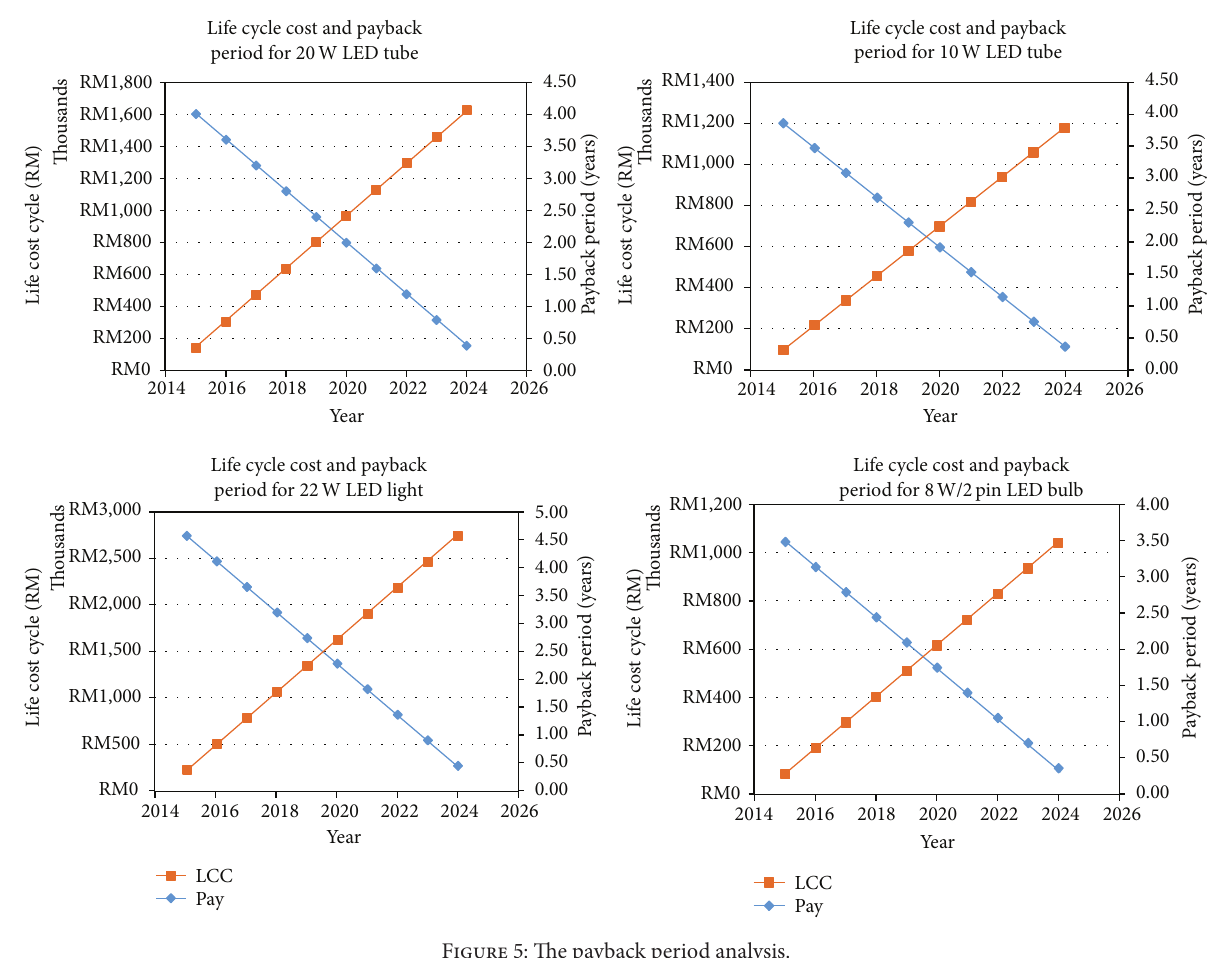
Figure 5: The payback period analysis.